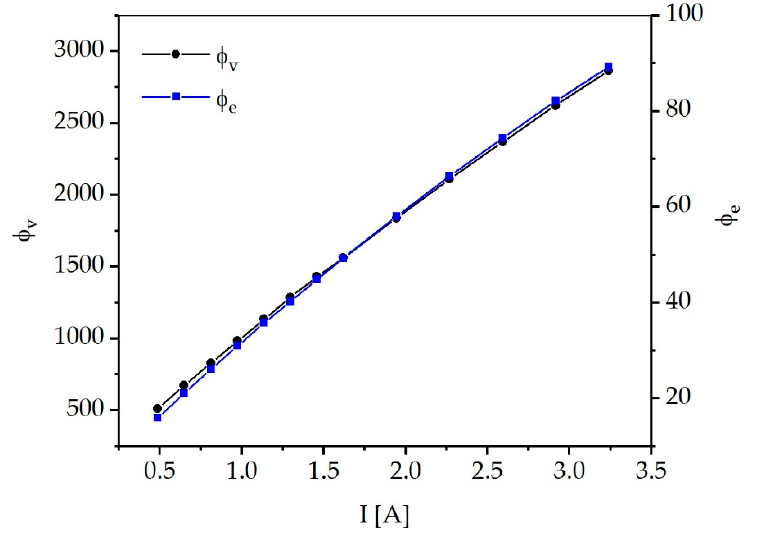
Figure 5. Radiant ( ф e ) and luminous flux ( ф v ) values for different currents between 0.486 and 3.240 A. This corresponds to an e ffi ciency of 62% for the conversion of electrical power into optical power, which indicates an e ffi cient mode of operation of the LED. Table 1 shows the remaining radiant flux and luminous flux values as a function of the current. It can be observed that the e ffi ciency decreases with increasing current. Therefore, the preferred operation at 70% of the electrical power constitutes a good compromise between high optical power and economical operation of the LED. Figure A1 in the Appendix shows the spectrum of the LED depending on the set temperature of the thermostat used for LED